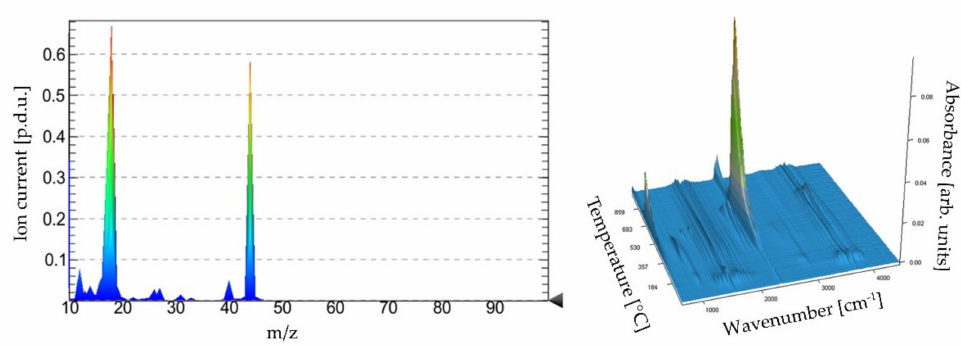
Figure 5. Mass and FT-IR spectra of volatile products of the thermal analysis of the